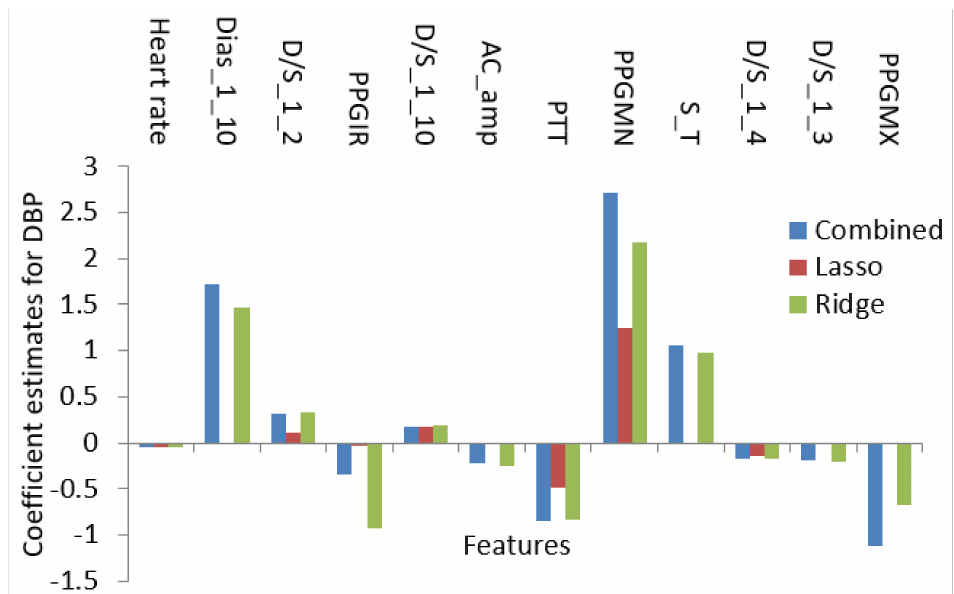
Figure 16. The value of the coefficient for penalty-based regression for DBP.